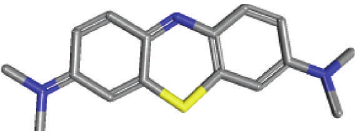
Figure 1: The chemical structure of methylene blue; a diaminophe-